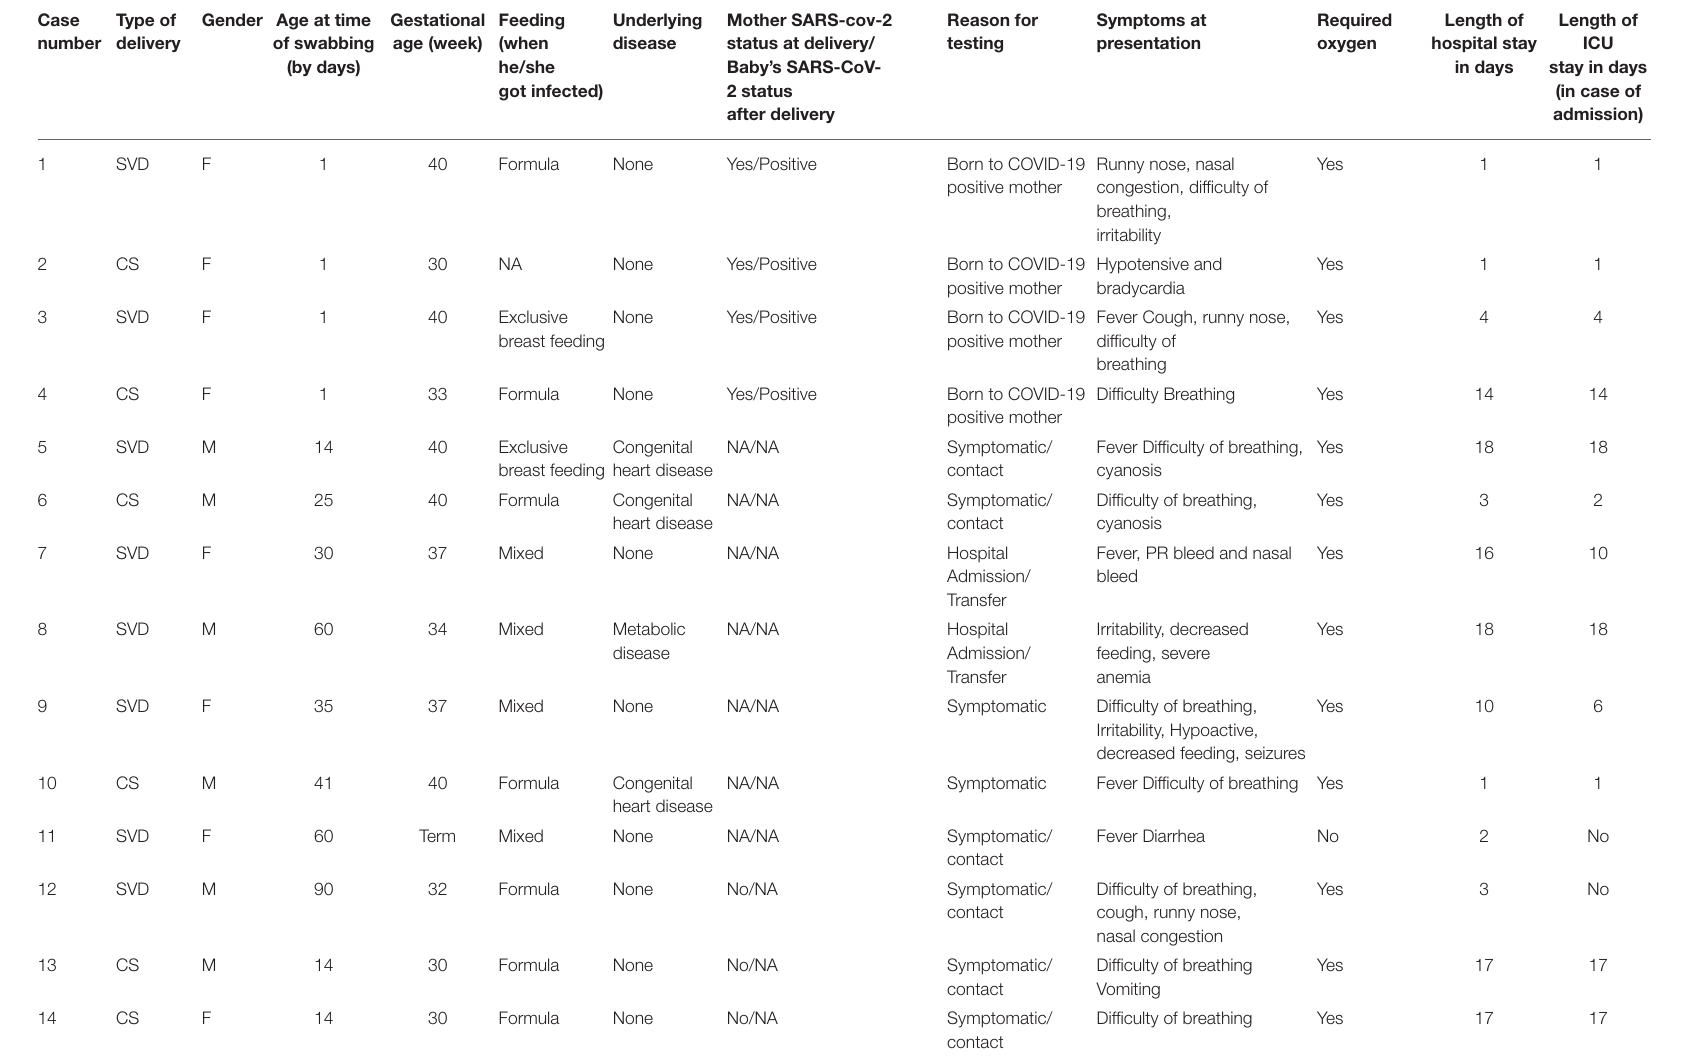
Formula None No/NA Symptomatic/